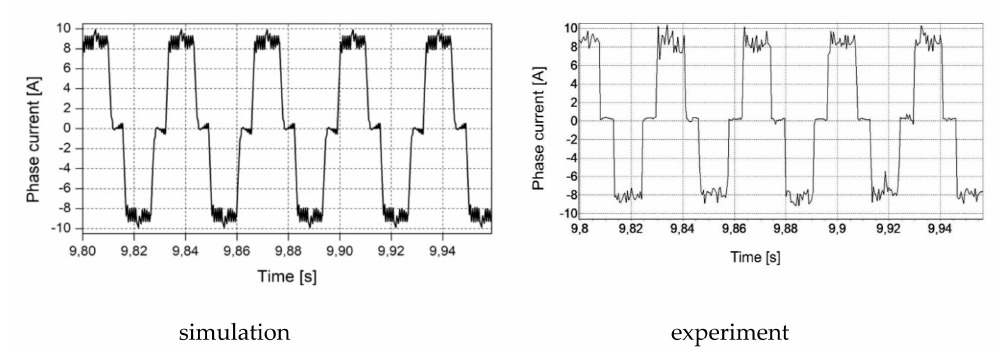
Figure 12. Phase current of BLDC motor under load vs.